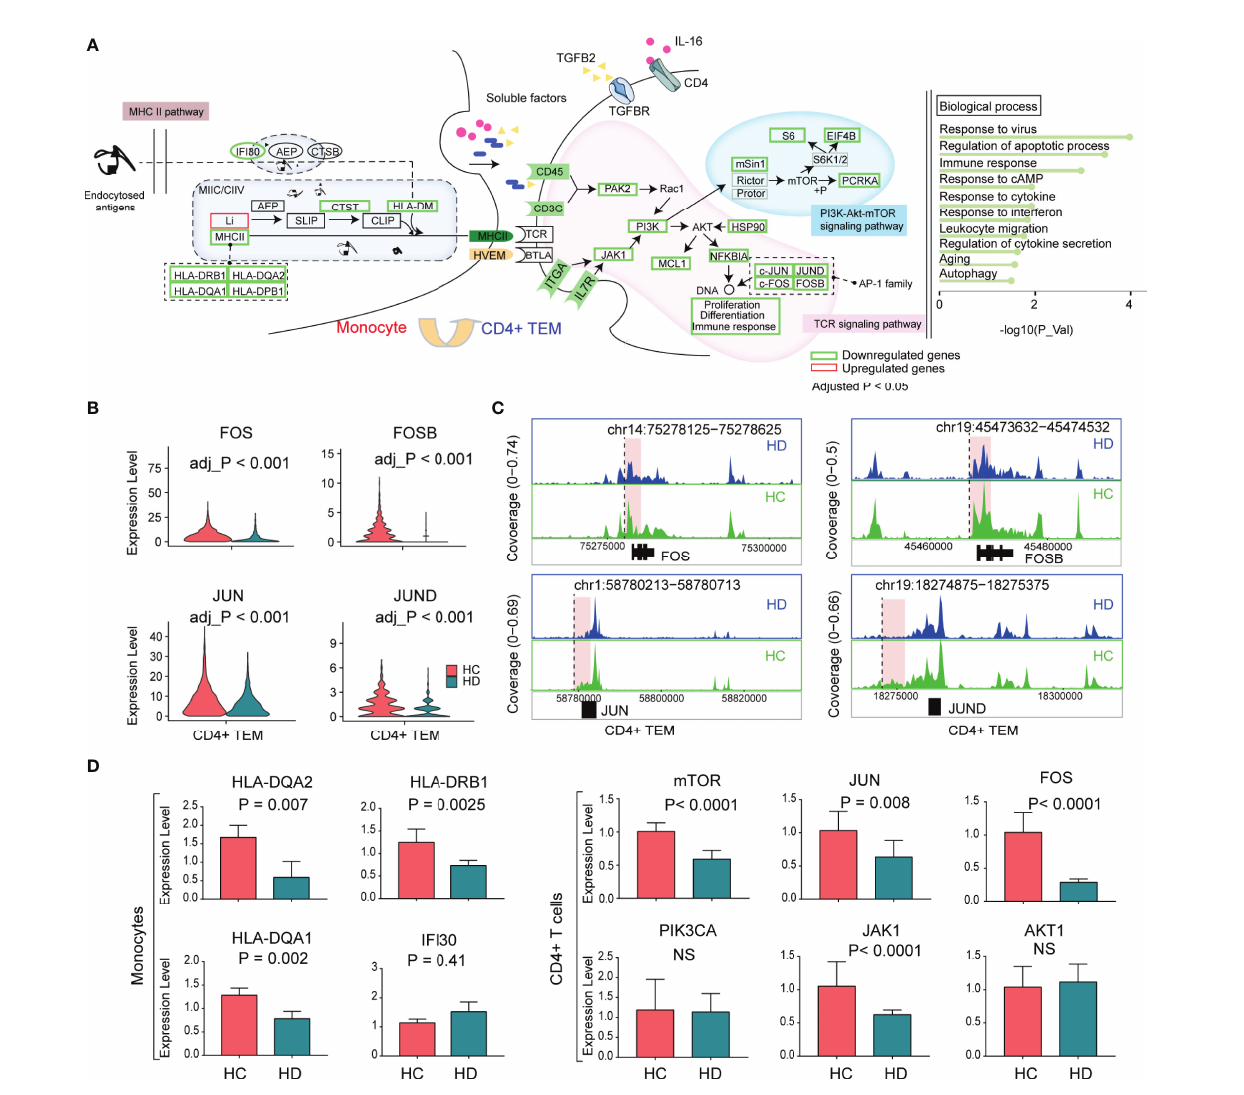
FIGURE 6 | The characteristic of the transcriptional regulation of CD4+ TEM in HD patients. (A) The schematic illustration of cellular communication between monocytes and CD4+ TEM cells in HD patients. (B) Violin plots showing the differential expression of AP-1 family TFs ( FOS , FOSB , JUN , JUND ) in CD4+ TEM between HD and HC groups. (C) Mean scATAC-seq coverage at FOS , FOSB , JUN , JUND locus in CD4+ TEM. Differential peaks are marked with red boxes. (D) Histograms showing the expression levels of genes validated by RT-qPCR. AP-1, activator protein 1; TFs, transcription factors; RT-qPCR, quantitative real-time polymerase chain